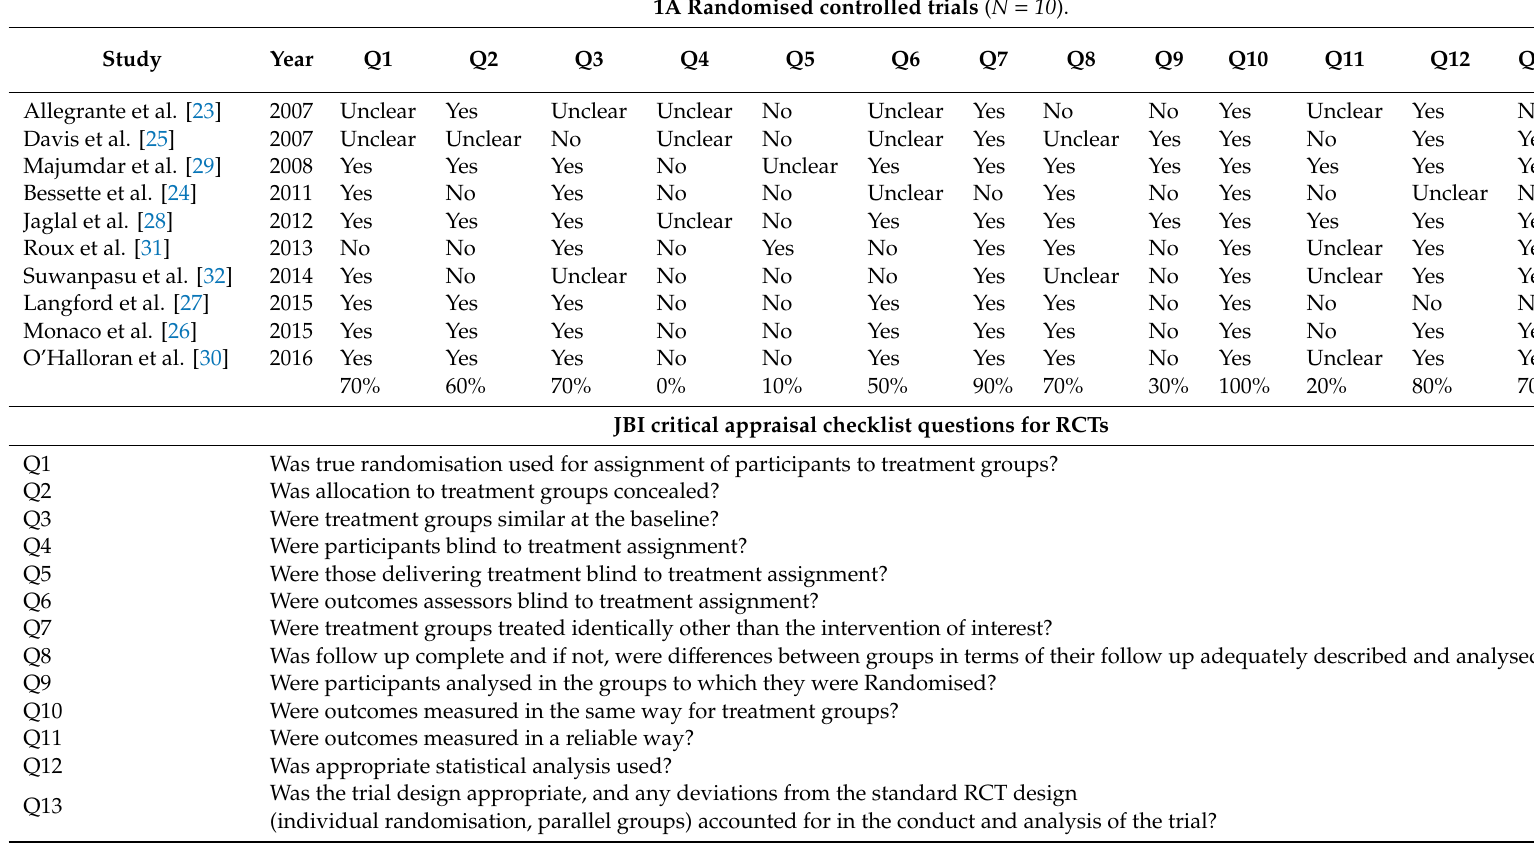
Table 1. Methodological quality